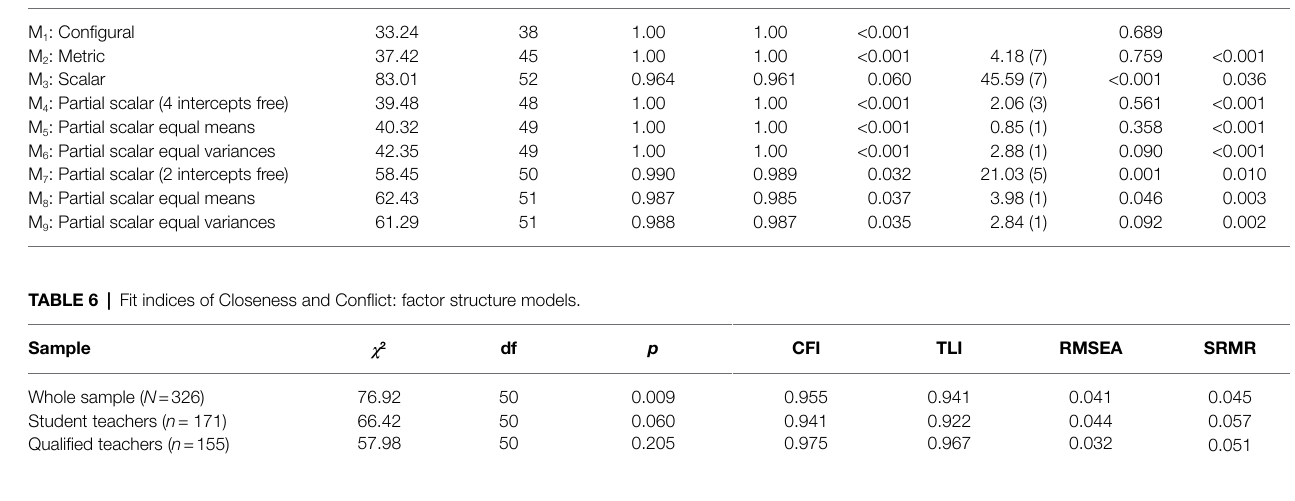
TABLE 5 | Fit indices of measurement invariance models of Culturally Inclusive Pedagogy. Model (M) χ 2 df CFI TLI RMSEA Δ χ 2 -test (df) p Δ CFI M 1 : Configural